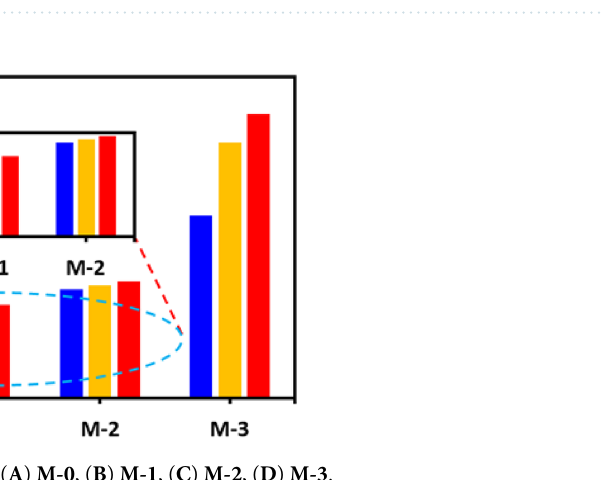
Figure 8. ( A ) Separation efficiencies of the pristine and PP- 5 modified PVDF membranes at different pressure for 1000 ppm oil-in-water emulsion and ( B ) Photographs of the 1000 ppm oil-in-water emulsion (Feed) and collected permeate from the PP-5 modified PVDF membrane.